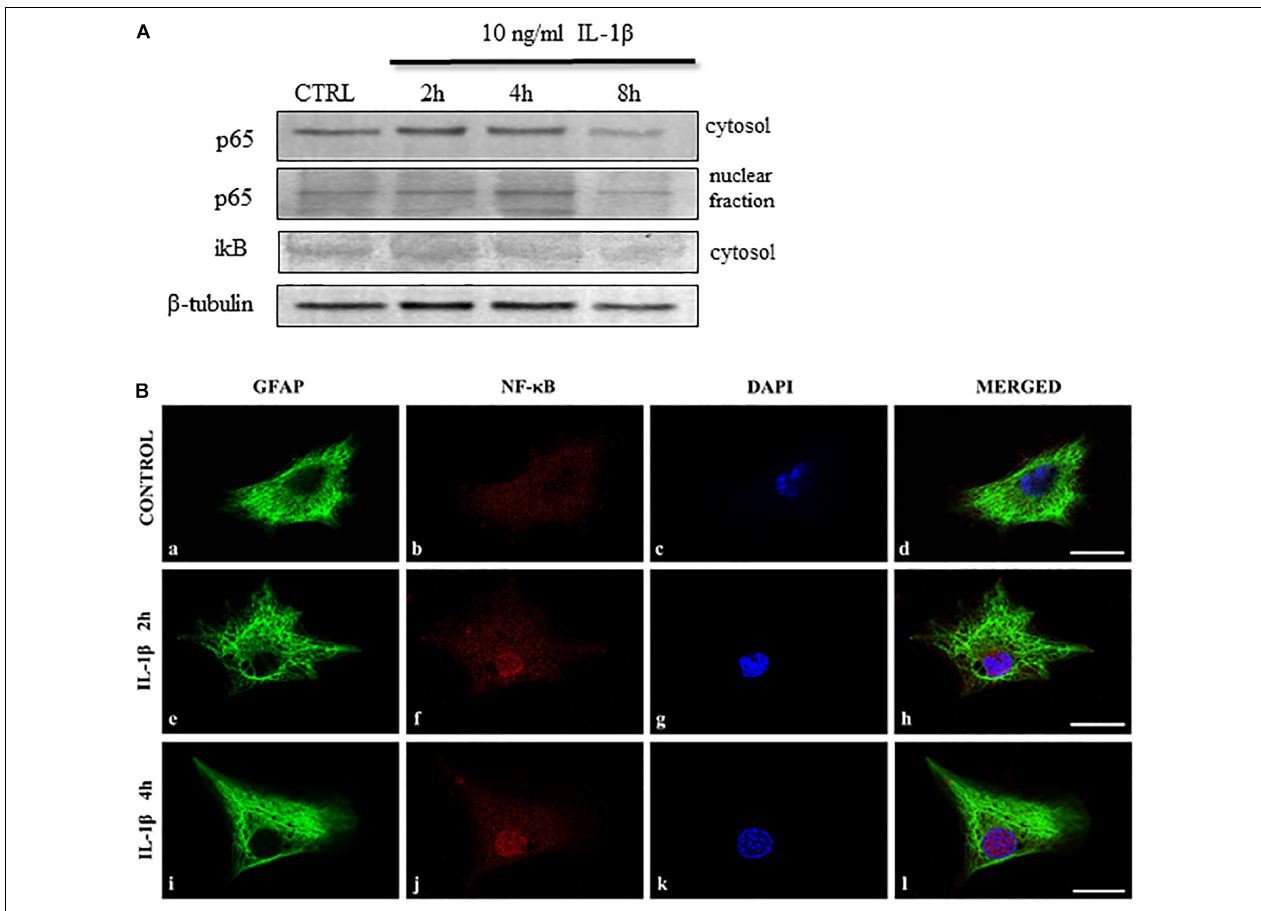
FIGURE 8 | IL-1 β activates the NF- κ B signaling pathway in spinal astrocyte cultures. (A) Representative immunoblots show time-dependent changes of the NF- κ B signaling pathway upon IL-1 β stimulation of spinal astrocyte cultures. NF- κ B p65 expression increase after 2 h of stimulation in the cytosol and the p65 protein appears in the nuclear fraction after 2 h of treatment. The inhibitory i κ B unit is downregulated in the cytosol of the cultures upon 4 h of stimulation. (B) Micrographs of single 1 µ m thick laser scanning confocal optical sections illustrating cytoplasmic expression [GFAP astrocytic marker (green)] of p65 protein in control cultures (panels a–d ). The nuclear translocation of the p65 protein was observed after 2 (panels e–h ) and 4 h (panels i–l ) of IL-1 β treatment. On all images DAPI was used to label cell nuclei (blue). Mixed color (purple) on the superimposed images ( d,h,l ) indicate double labeled structures. Scale bars: 10 µ